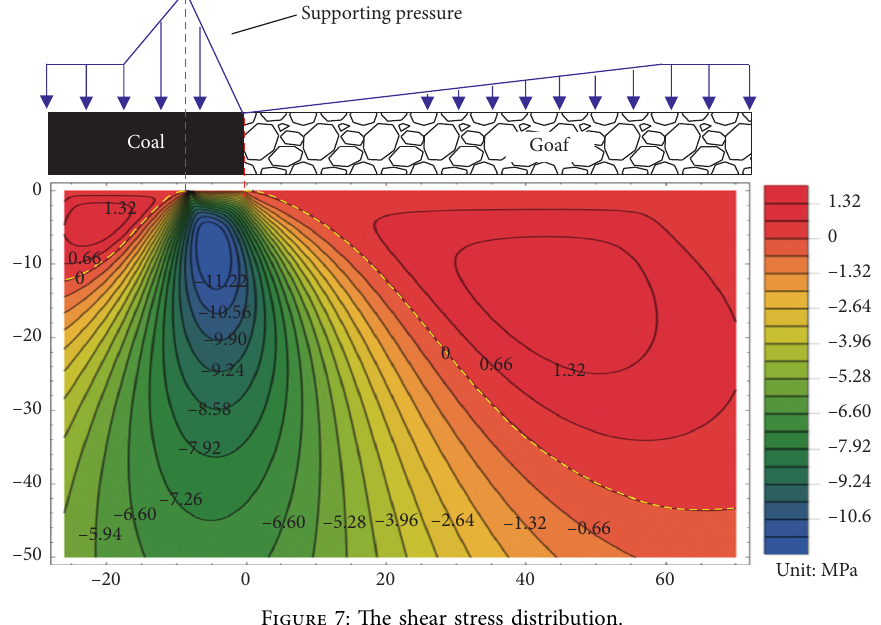
Figure 7: The shear stress distribution.